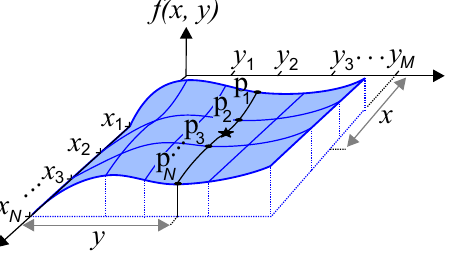
Figure 5. Interpolation in two